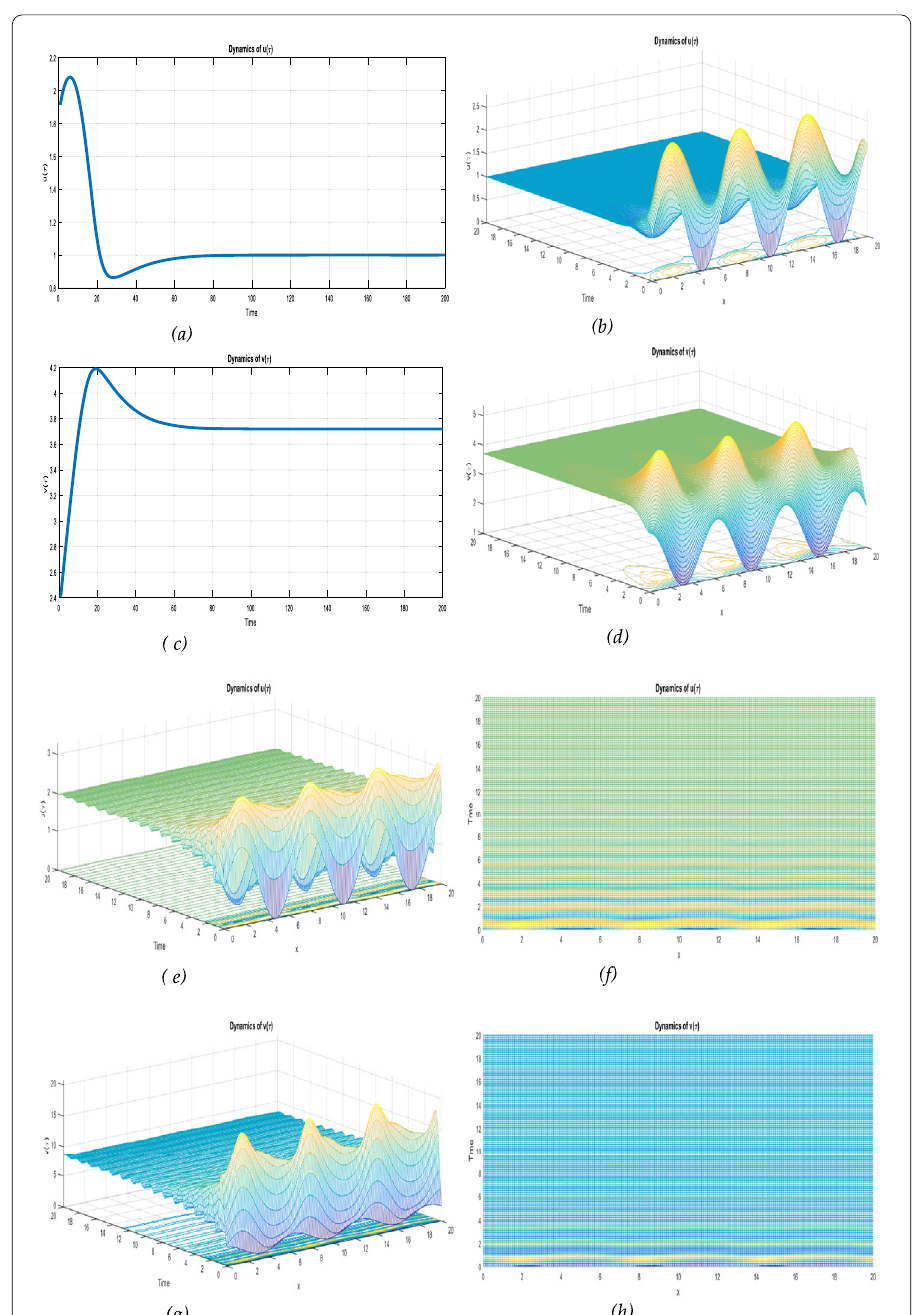
Figure 4 ( a )–( d ) Numerical solutions of system (49) using forward Euler scheme. Here, u 0 = 1 + sin( x ) and v 0 = 2 + cos( x ), with l = 5, m = 1, κ 1 = 0.01, and κ 2 = 0.01. (Top) The concentration of u ( τ ) is on the left while the concentration of v ( τ ) is on the right. (Bottom) The solutions v ( x , τ ) and u ( x , τ ) tend to the constant steady state. ( e )–( h ) Numerical solutions of system (49) using forward Euler scheme. Here, u 0 = 1 + sin( x ) and v 0 = 2 + cos( x ), with l = 10, m = 20, κ 1 = 0.01, and κ 2 = 0.01. (Top) The solutions v ( x , τ ) and u ( x , τ ) tend to the spatially homogeneous periodic orbit. (Bottom) The projected views onto the x τ -plane at τ = 20 for v ( x , τ ) and u ( x , τ ). The stripe structure invades the nonhomogeneous steady states for u ( x , τ ) and v ( x , τ